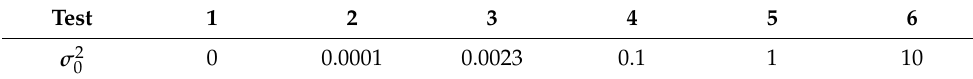
Table 4. Initial values of the